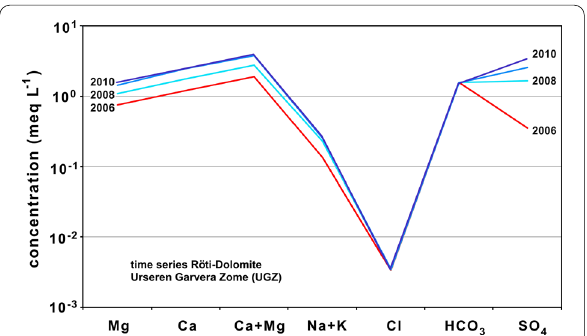
Fig. 11 Major components of water inflow (meq L − 1 ) at observation point 22.467 (Röti-dolomite in the Urseren-Garvera-Zone, UGZ) for different sampling dates (Schöller diagram): Red data from 2006, blue from 2008 to 2010. Sample UF 6 is listed in additional file 1: Table S1